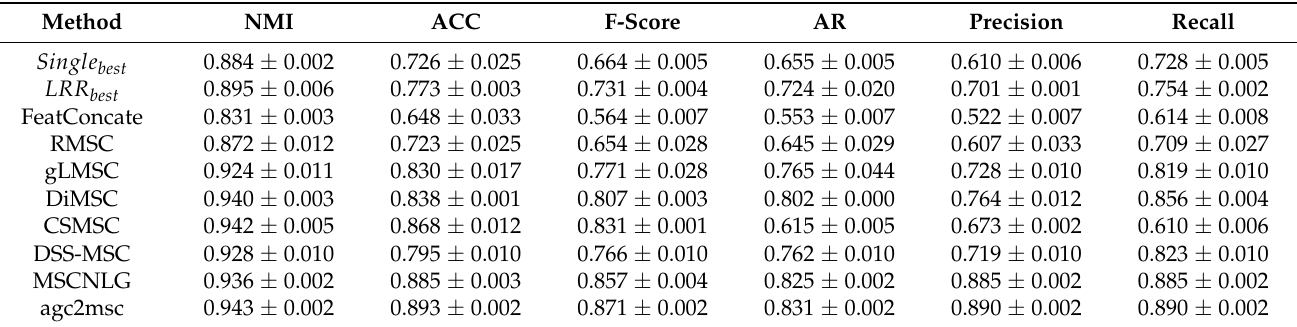
Table A2. Clustering results of the ten methods on ORL.